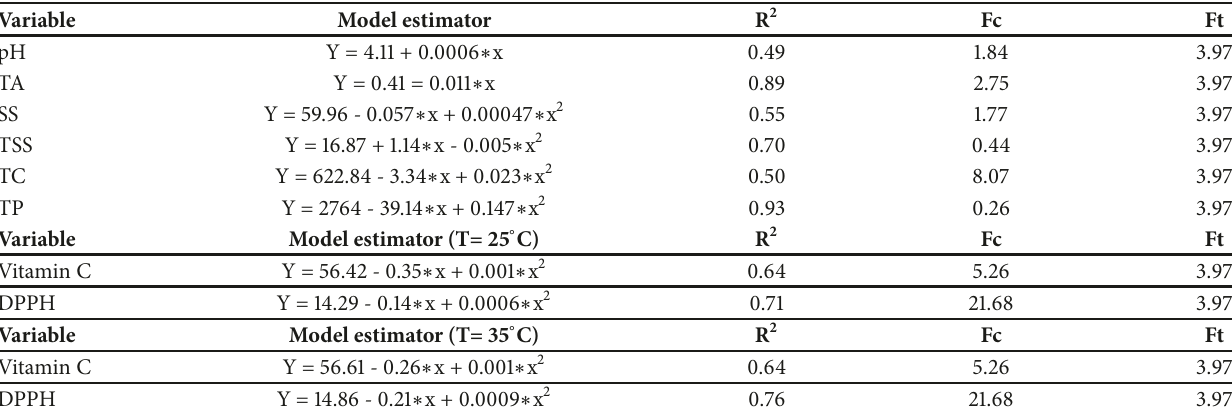
Table 2: Regression equations adjusted for variables that do not present significant interaction between temperature and storage time (0, 70, 105, 140, and 180 days) and for variables that have a significant effect of the interaction between the mixed jam storage times (0, 70, 105, 140, and 180) and temperature (25 ∘ c and 35 ∘